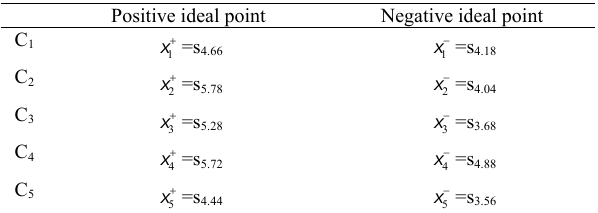
Table 7. The positive/negative ideal solutions.